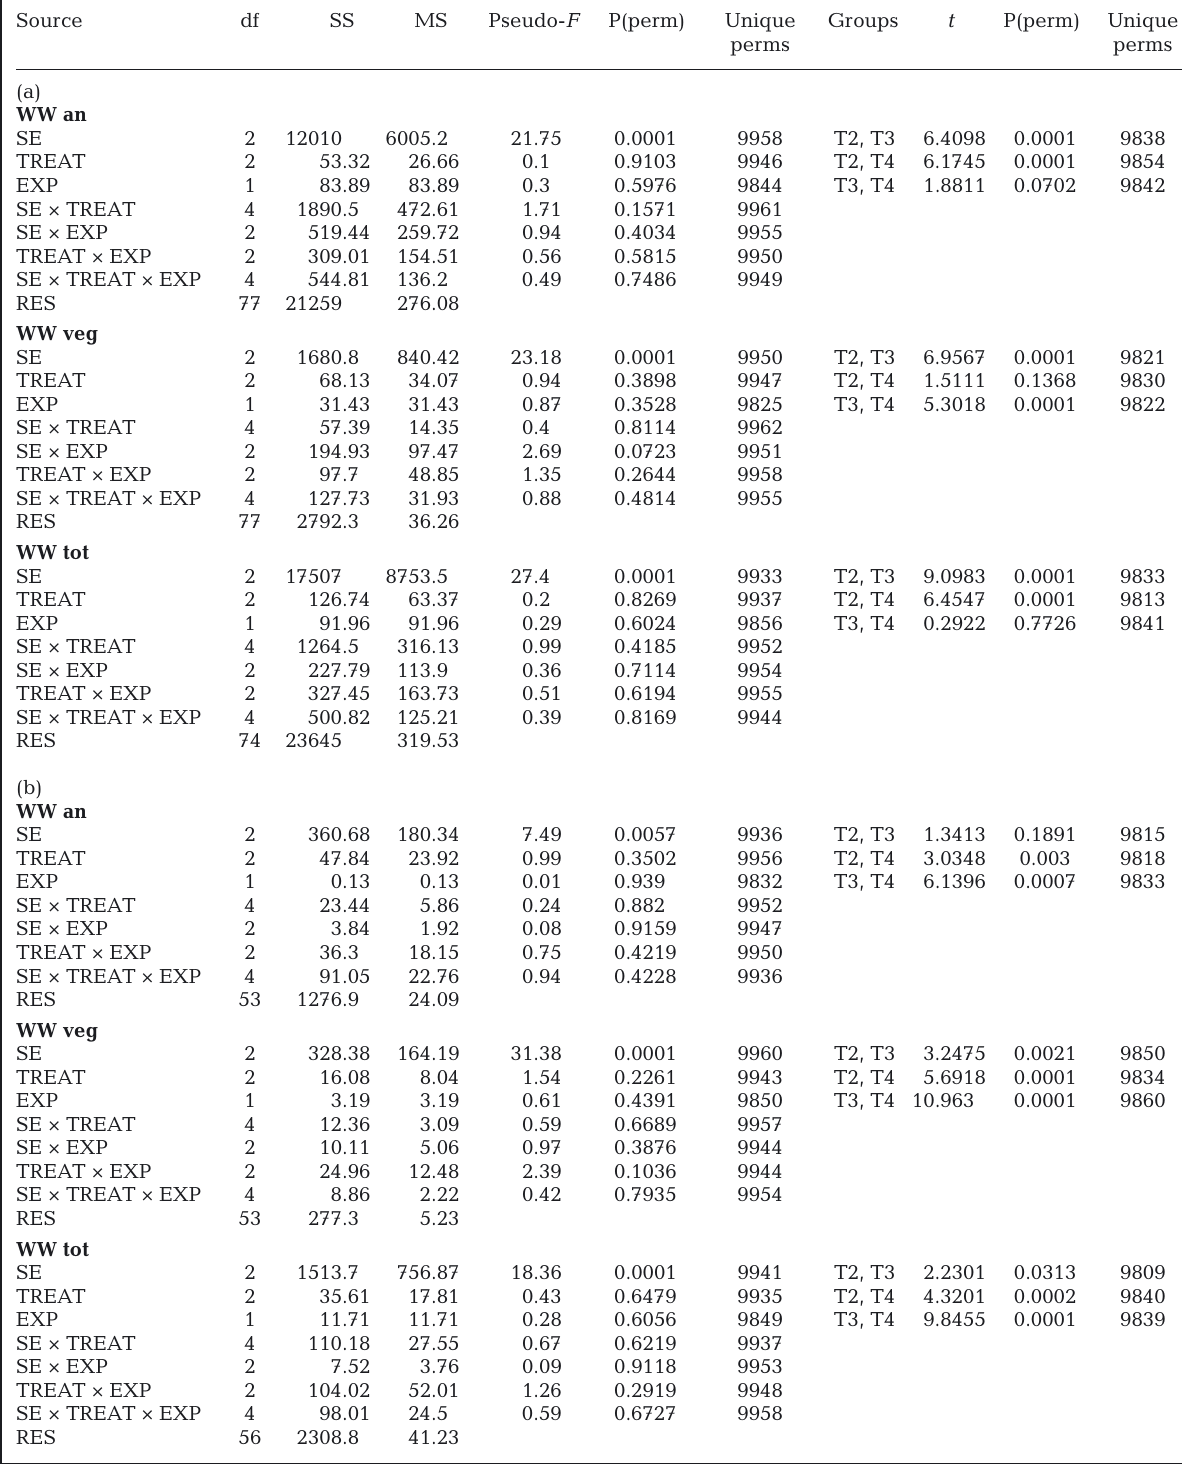
Table 3. PERMANOVA of results and group analysis for wet biomass (WW, g); animal (WW an), algal (WW veg) and total (WW tot); during different sampling periods. (a) Panels collected after 6, 9 and 12 mo (Group A); (b) 3 mo old panels submerged